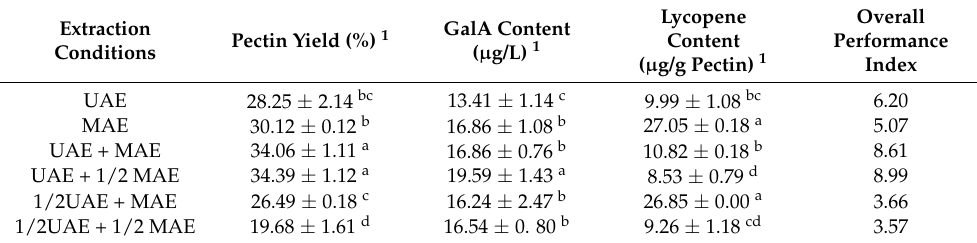
Table 2. The pectin yield, galacturonic acid (GalA), and lycopene content of obtained pectin and overall performance index of each MAE condition.